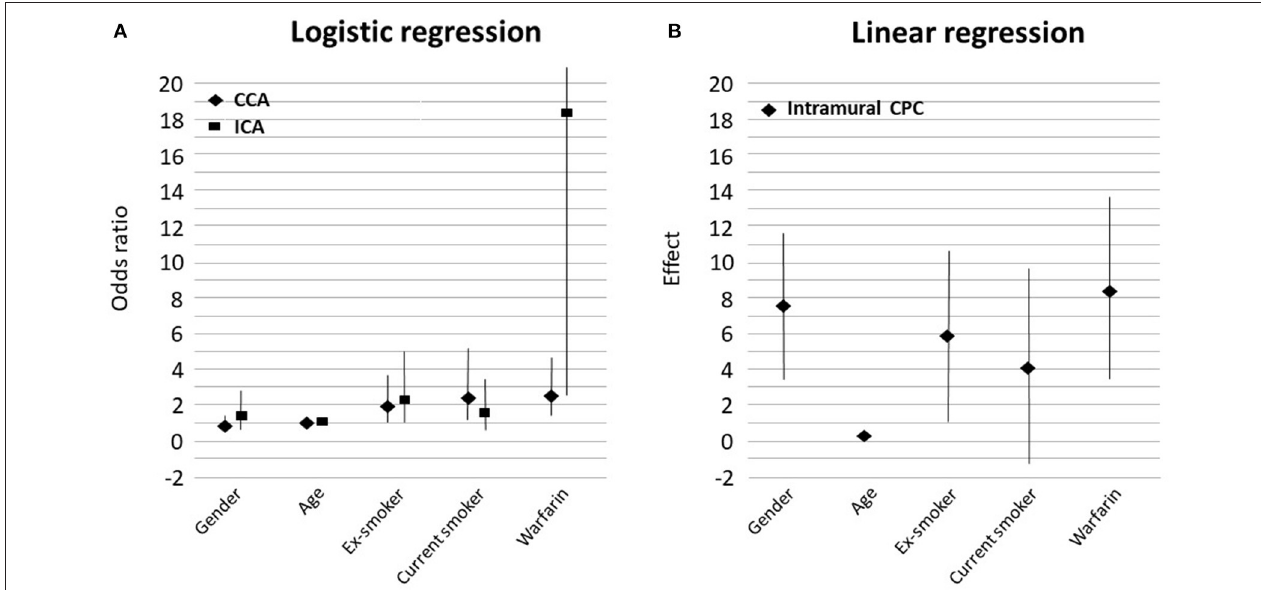
FIGURE 3 | Graphs showing the strength of association between variables in the multivariable model and the radiological evidence of calcification (A) and linear regression results for the histological evidence of calcification (B) . Female gender favored intramural calcification. CCA, common carotid artery; ICA, internal carotid artery; CPC, carotid plaque